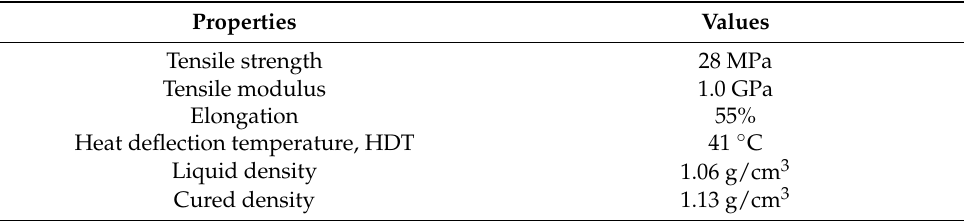
Table 1. Technical parameters for Durable Resin V2 [46].